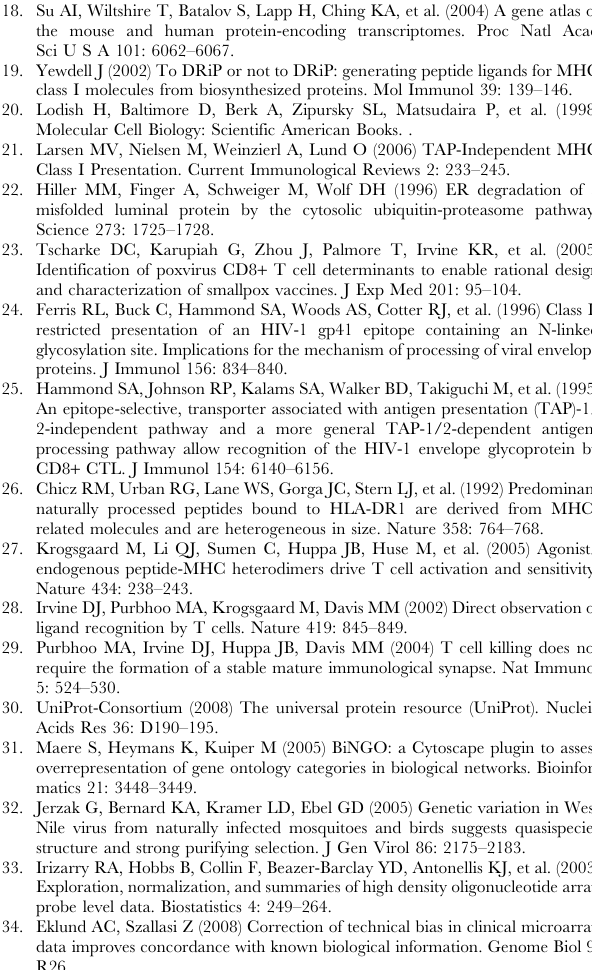
Table S2 Localisation analysis of proteins containing MHC class II ligands. The analysis was done using the Cytoscape plugin BINGO on proteins in the MHCII data set. The entire human protein set was used as background. GO-ID: The ID number of the GO cellular component term. p-value: p-value indicating the statistical significance of the difference between the fraction of proteins containing MHC class II ligands assigned to this GO term and the fraction of all proteins within the human protein set assigned to this GO term. corr p-value: The above p-value corrected for multiple testing by the Benjamini & Hochberg correction method. x: The number of MHC class II-containing proteins assigned to this GO term. nX: The number of proteins within the entire human protein set assigned to this GO term. N: The total number of MHC class II-containing proteins with assignments within the GO cellular component ontology. nN: The total number of proteins within the human protein set with